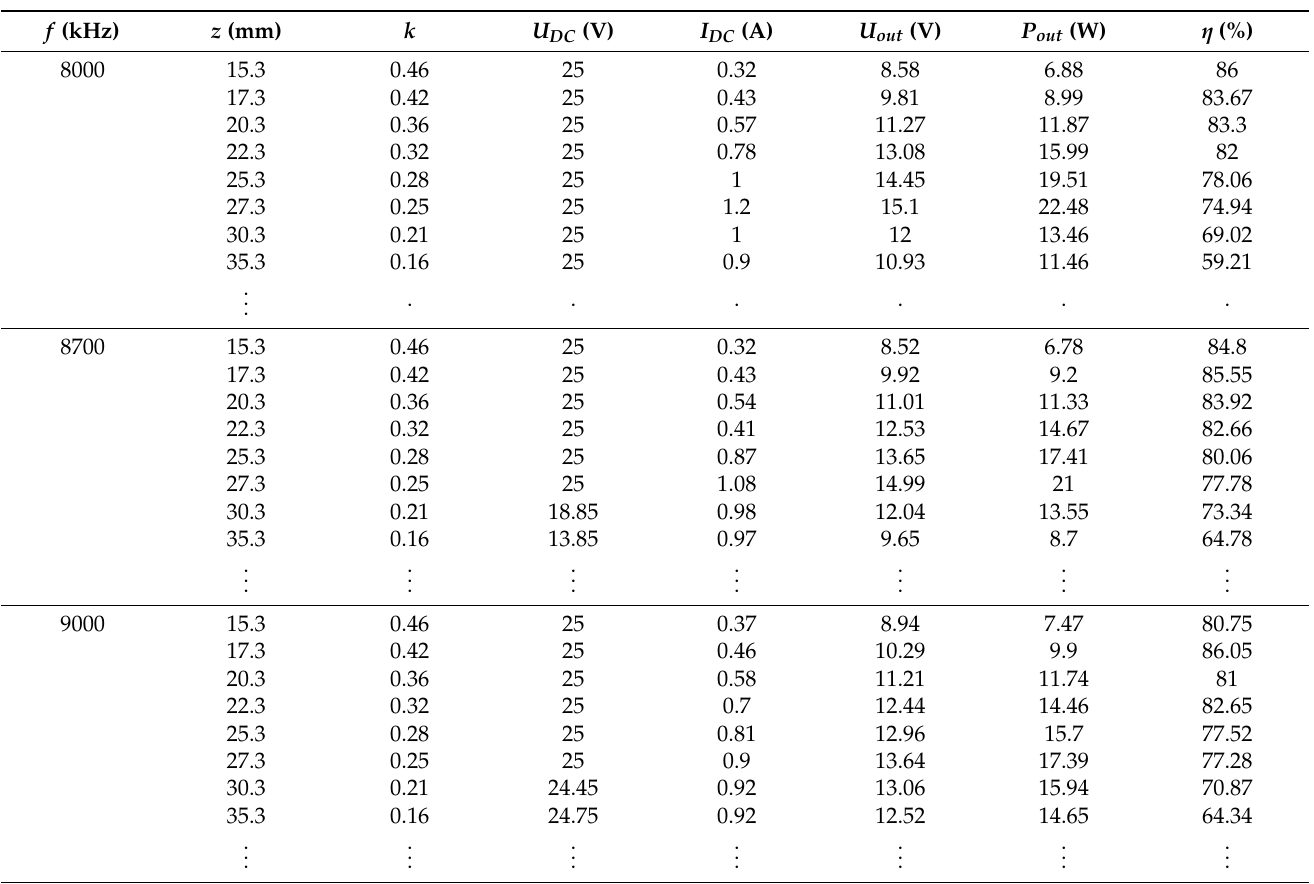
Figure 17. Efficiency of the IPT using the double DD coil structure: ( a ) at different frequencies; ( b ) average system efficiency. Table 6. Single DD IPT system at different resonant